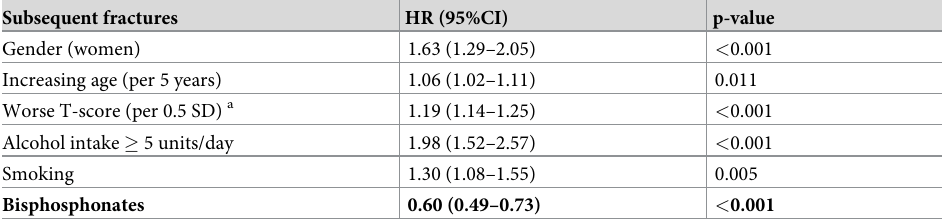
Table 2. Predictors of subsequent fractures. Multivariable Cox regression model; values are presented as hazard ratios (HR) with 95% confidence intervals (95%CI).